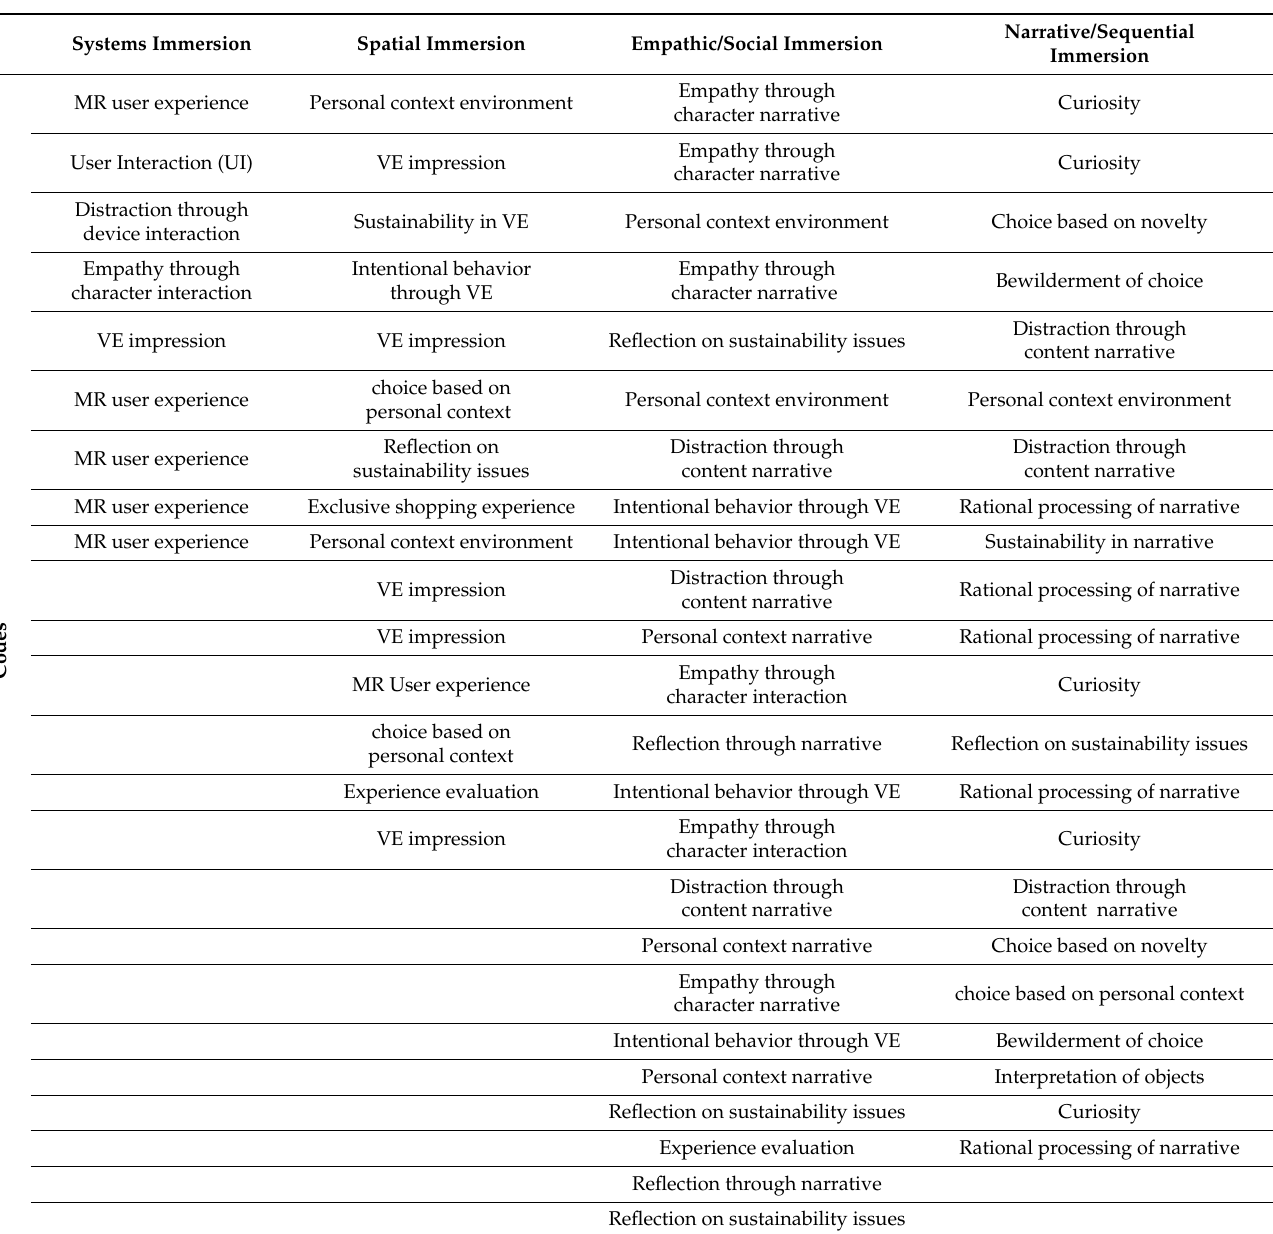
Table 3. Codes corresponding to immersive experience